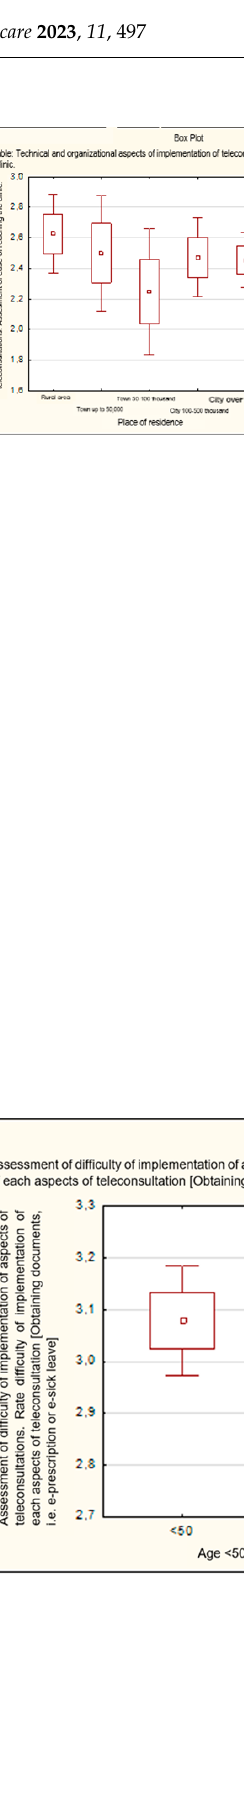
Figure 2. Assessment of the difficulty of obtaining an e-prescription by age and gender. 3.3. Overall Effectiveness of Teleconsultation Using a scale of 1–5, where 1 was the worst and 5 was the best, the respondents first assessed the scale of their difficulty with understanding the information provided by the doctor. The results indicated that this was not a major challenge. In total, less than 13% chose the worst or second worst option (1 or 2).